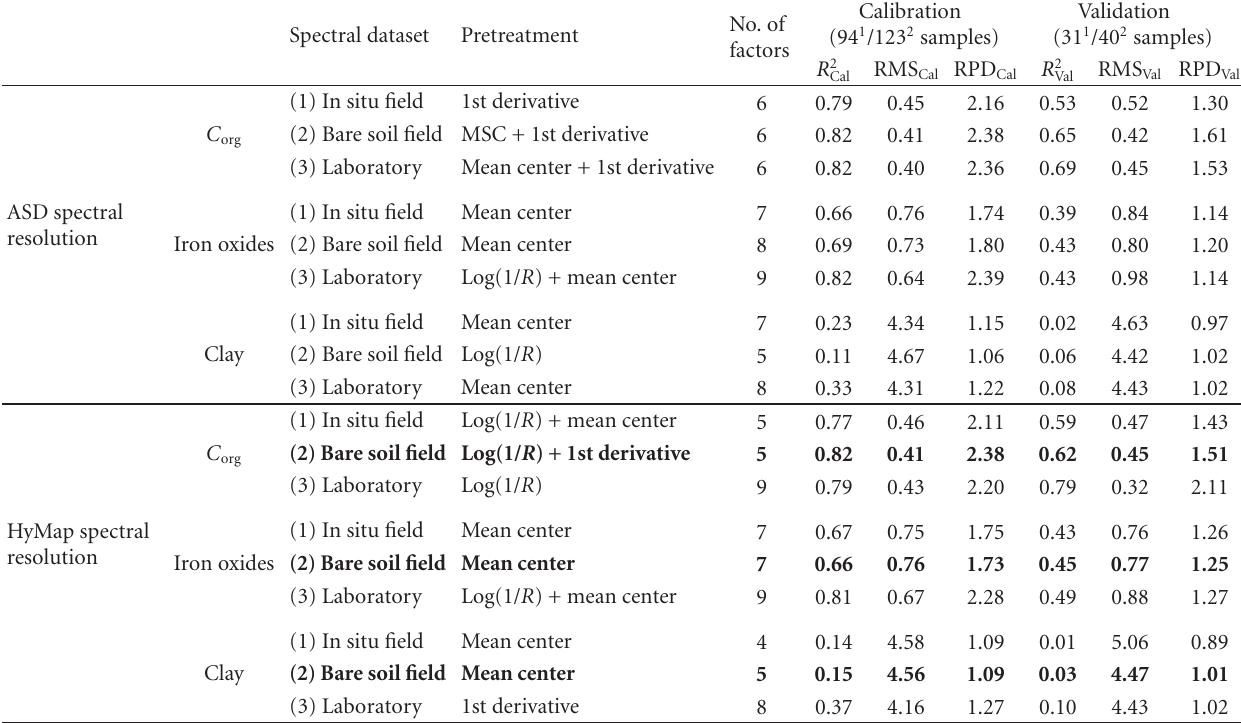
Table 5: Calibration and validation accuracies for approach B—partial least squares regression. The models further to be applied for a large-scale prediction of soil constituents based on HyMap imagery are